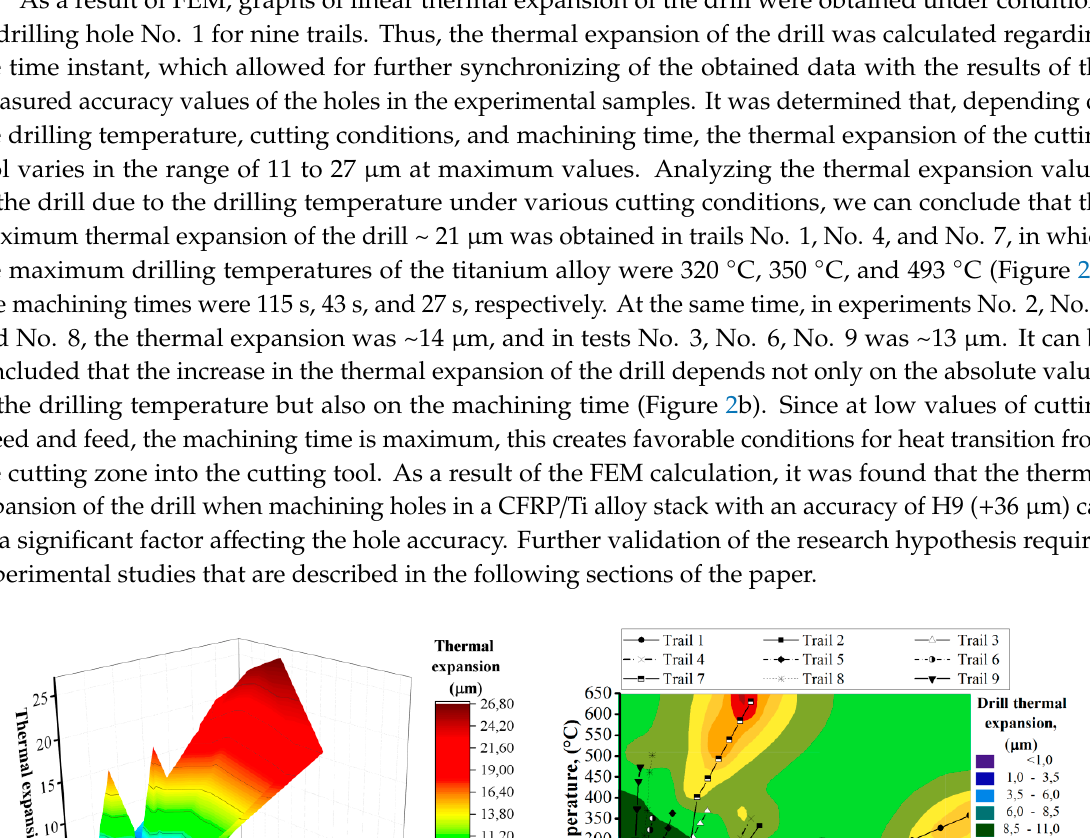
Figure 2. Results of finite element modeling of drill thermal expansion. ( a ) evaluation of